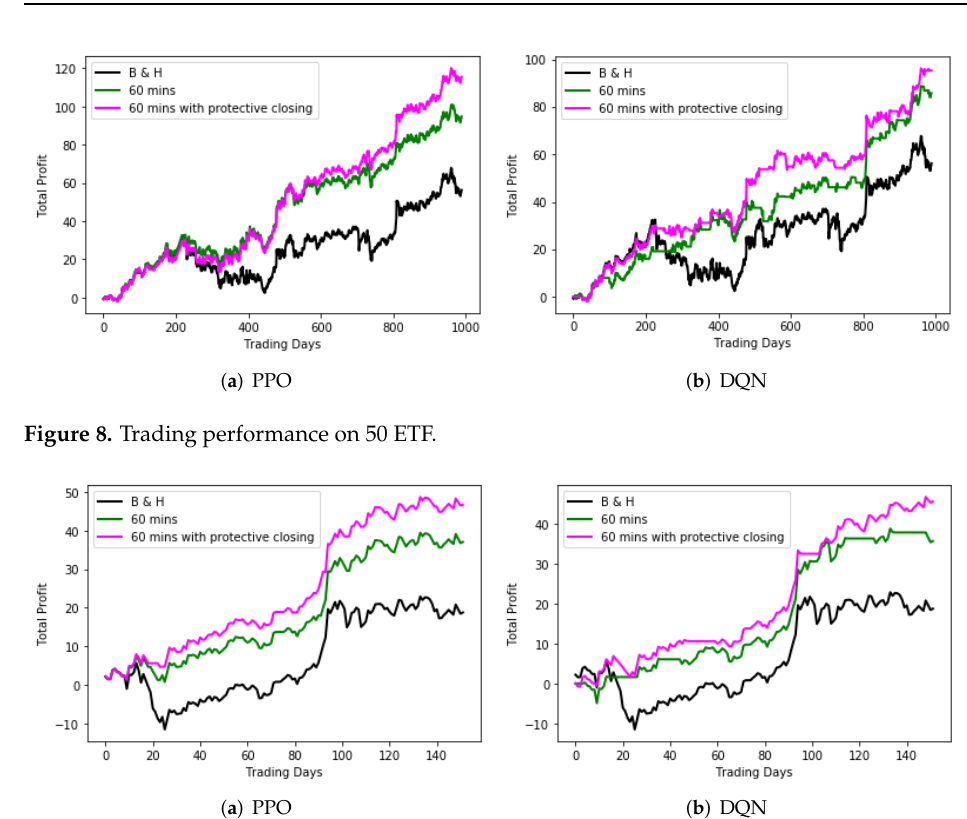
Figure 9. Trading performance on 300